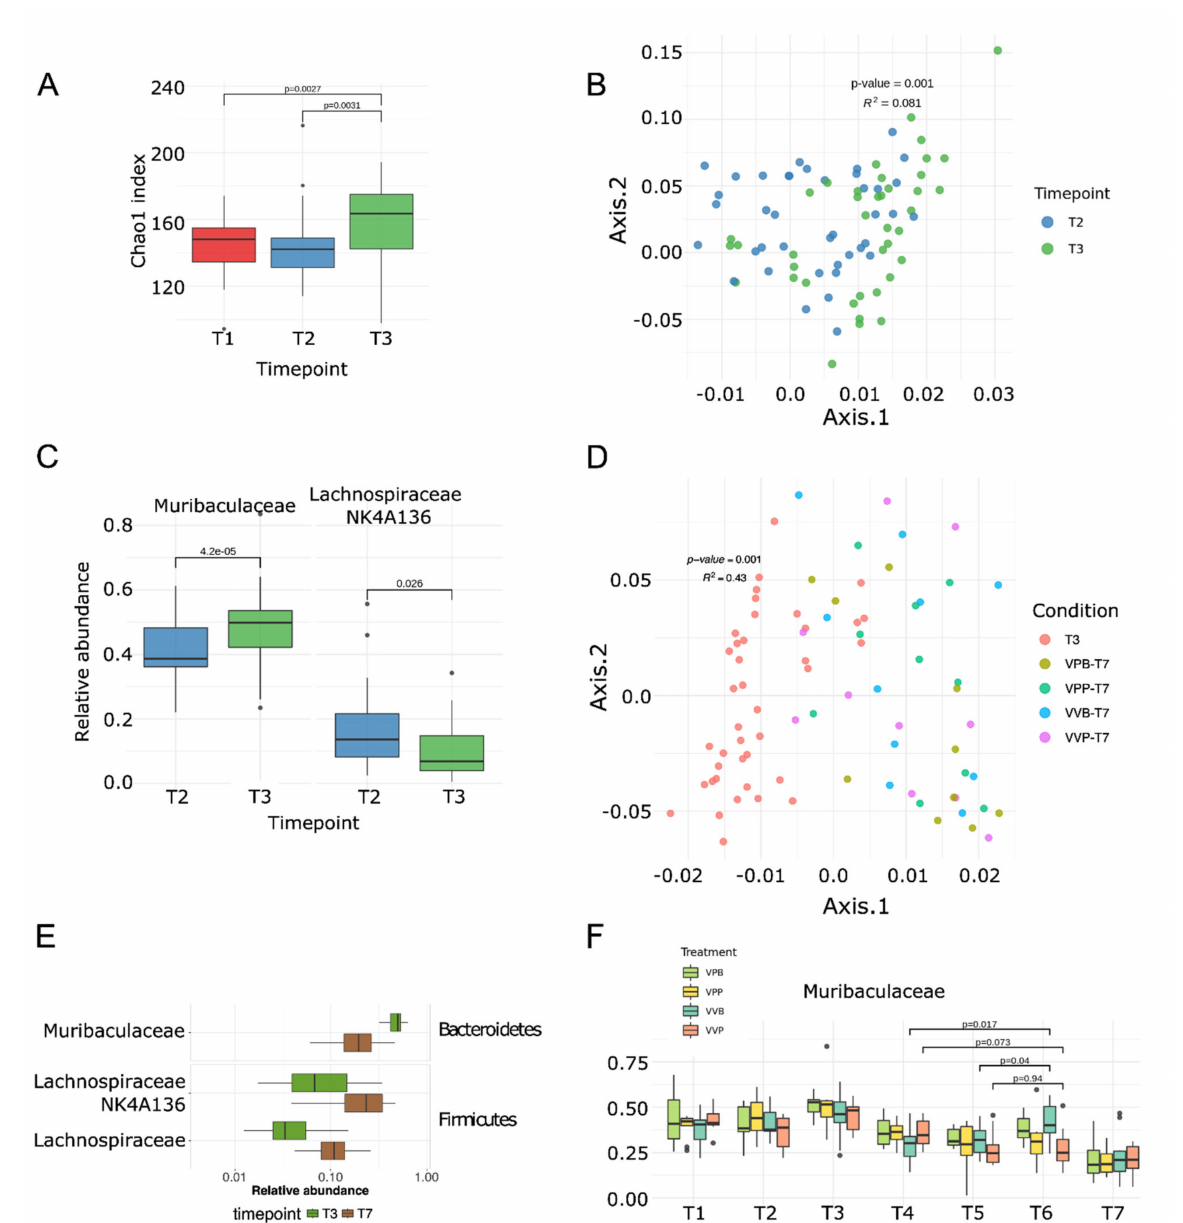
Figure 3. Microbiome variations identified by 16s rRNA sequencing. ( A – C ) Alteration of microbiome composition at tumor injection (T1/T2 vs. T3) as measured by alpha diversity index Chao1 ( A ), multidimensional scaling (MDS) on samples using the Weighted UniFrac measure ( p = 0.001, PERMANOVA with 999 permutations) ( B ) and relative abundance distribution of key bacteria ( C ). This later analysis shows an increase in relative abundance of bacteria belonging to the Muribaculaceae group ( q -value = 4.2 × 10 − 5 Wald test) and a decrease in the genus Lachnospiraceae NK4A136 ( q -value = 0.026 Wald test). ( D – E ) Comparison of gut microbiome in mice at T3 and T7. Multidimensional scaling (MDS) on samples using the Weighted UniFrac measure showed a statistically significant difference ( p = 0.001, PERMANOVA with 999 permutations). ( D ) Differ- entially abundant species between T3 and T7 (Wilcoxon test). Only species found to be significantly differentially abundant after false discovery-rate error correction ( p adj < 0.05) and with a median relative abundance >0.01 are reported. ( E , F ) Boxplot of relative abundances of Muribaculaceae across timepoints and separated by treatment. Muribaculaceae was altered after administrating the Bifidobacterium in mice vaccinated with nondecorated vesicles. VPB: Pentatope OMVs + Bifidobacterium gavage; VPP: pentatope OMVs; VVB: empty OMVs + Bifidobacterium gavage; VVP: empty